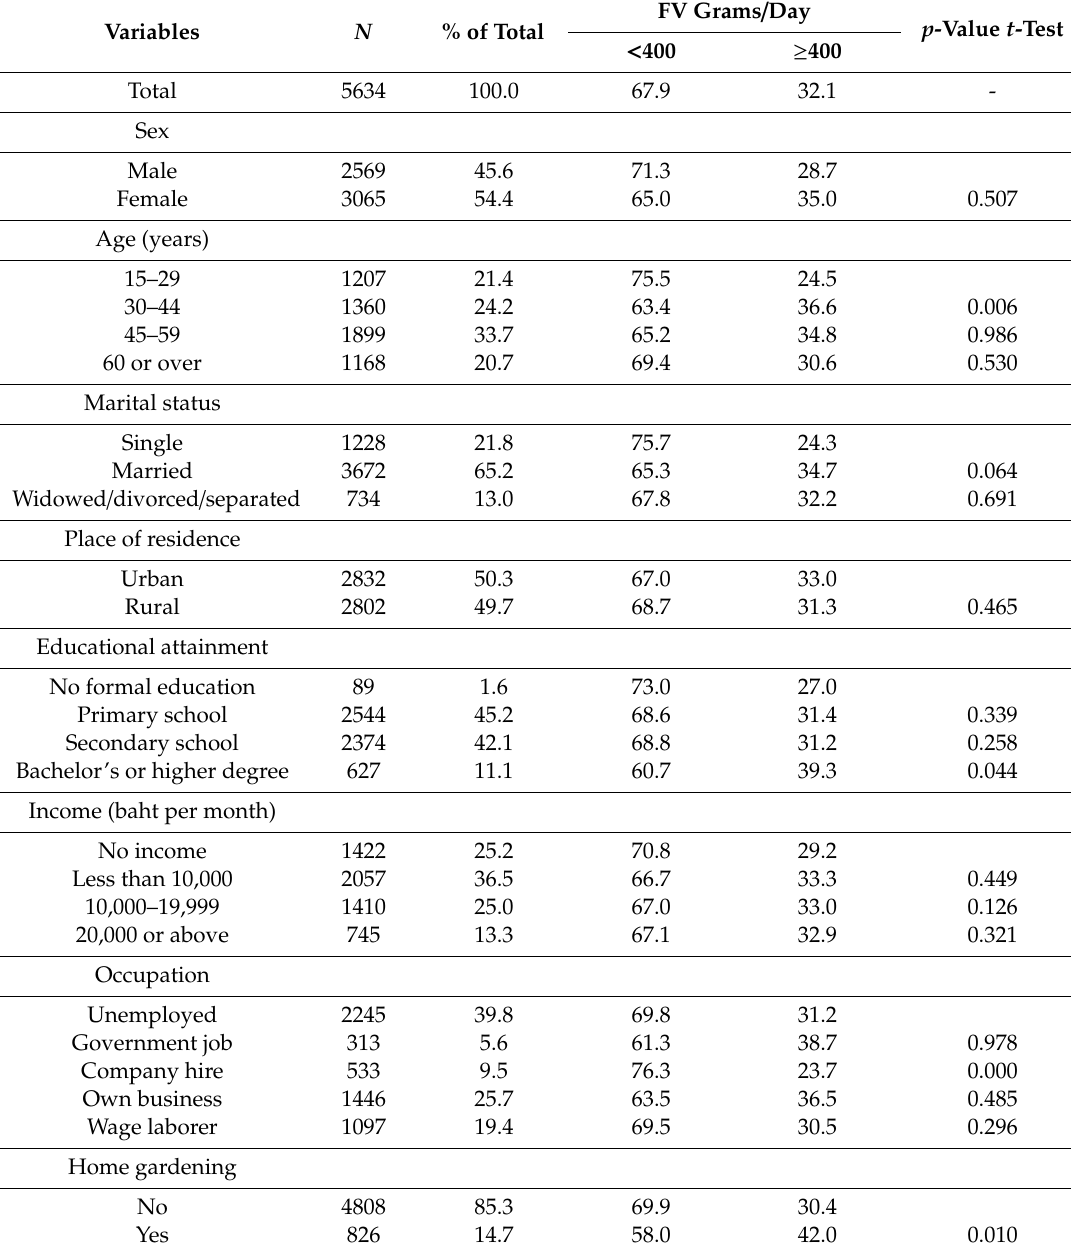
Table 1. Socio-demographic characteristics and home gardening for su ffi cient FV intake in the non-farming population ( N =